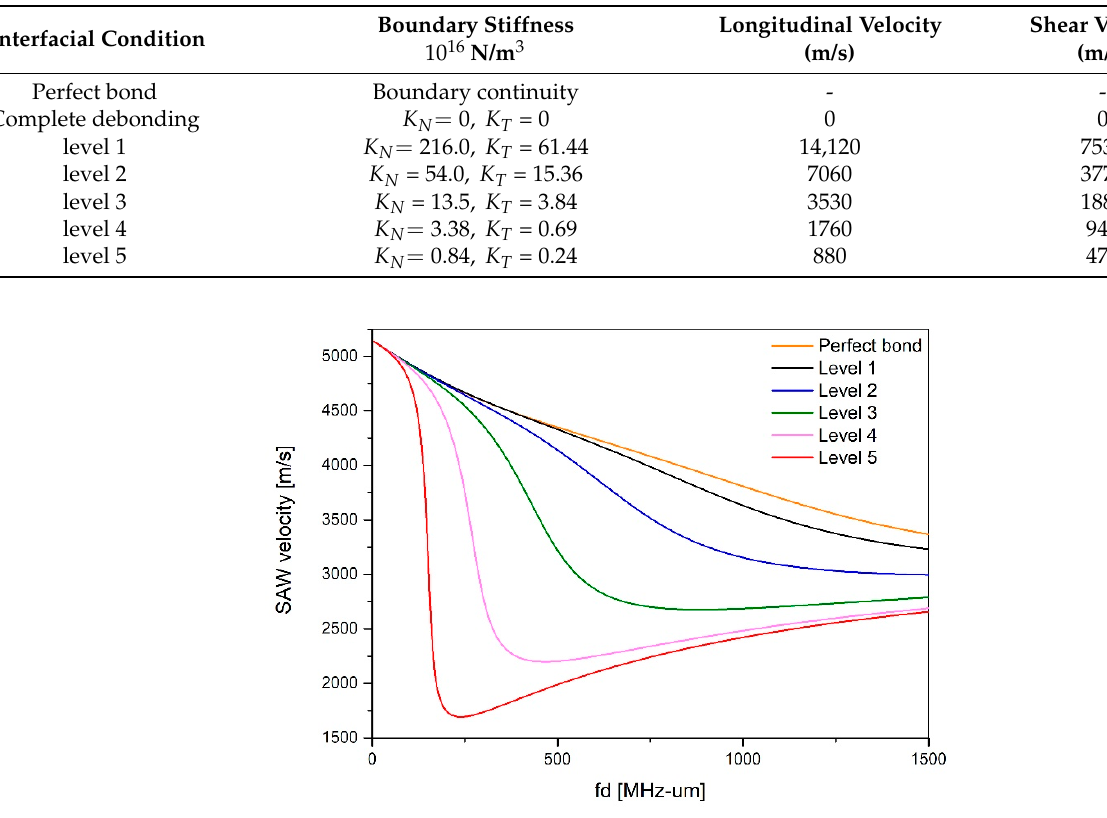
Table 1. Stiffness coefficient according to the bonding interface condition of multilayer thin film.